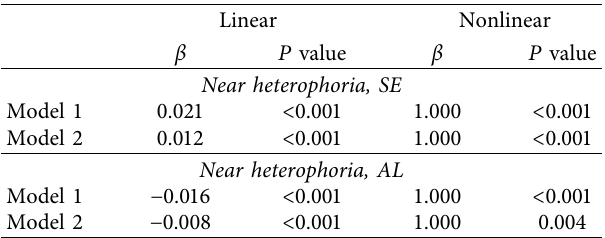
Table 4: Generalized additive model analysis of the effect of near heterophoria on SE or